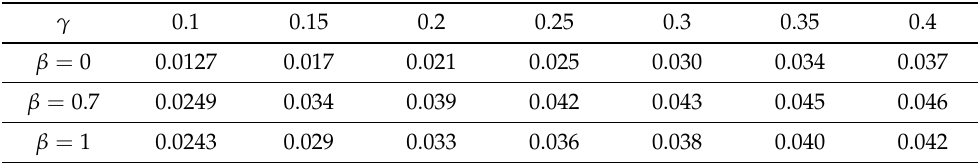
Table 1. Maximum allowable τ for various of γ and β values in Case 1.